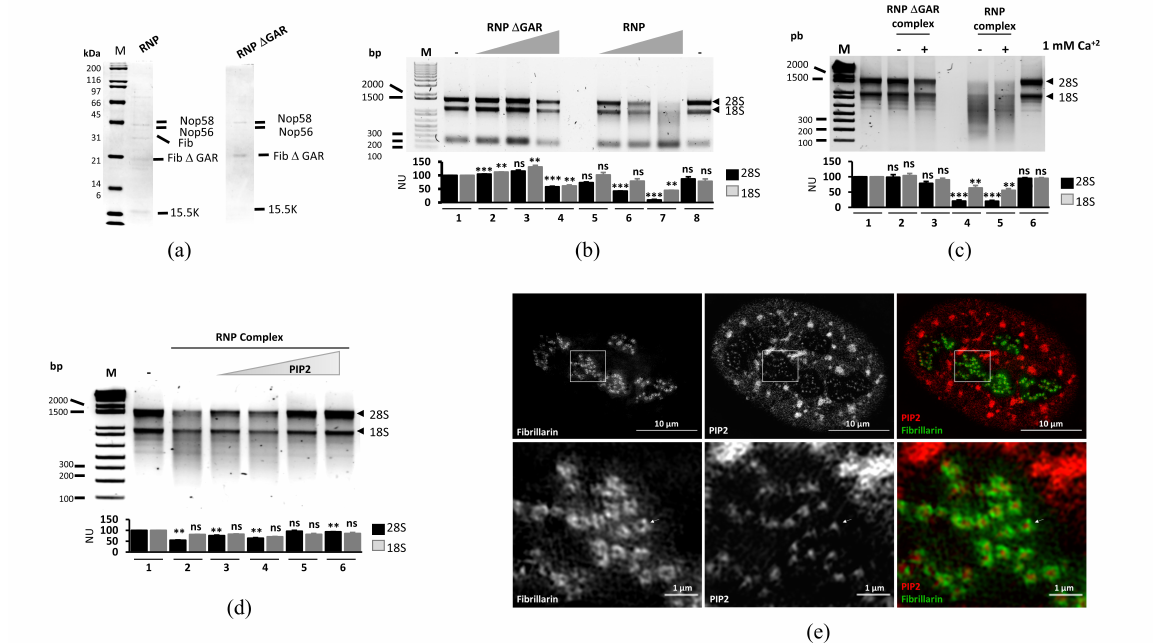
Figure 2. RNA activity of the recombinant ribonucleoprotein complex containing a truncated